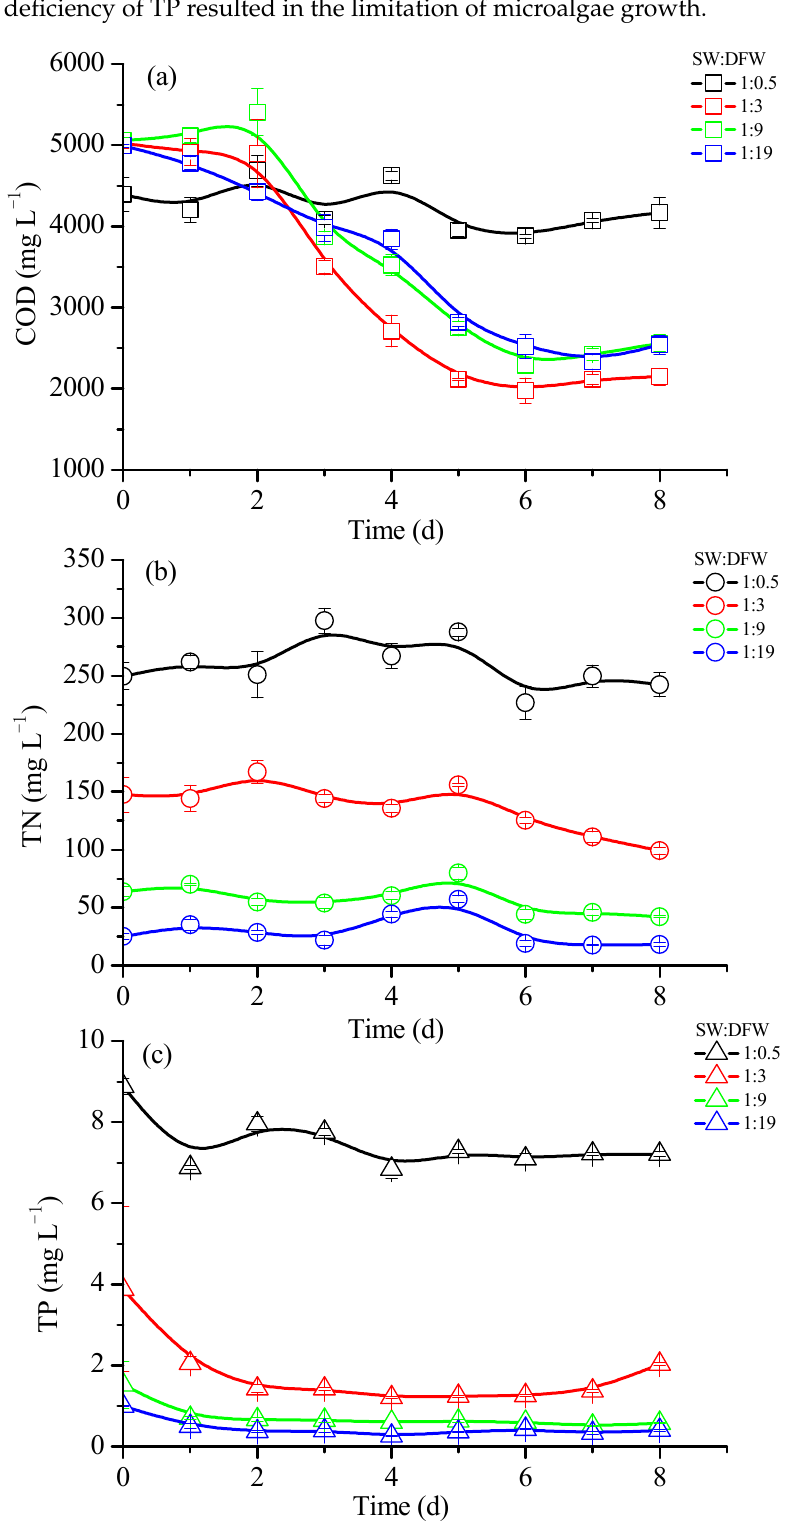
Figure 2. Removal performance of COD ( a ), TN ( b ) and TP ( c ) by C. pyrenoidosa cultured in mixed wastewater with different ratios of swine wastewater (SW) to diluted furfural wastewater (DFW). The COD values of mixed wastewaters at the mix ratios of SW:DFW = 1:3, 1:9 and 1:19 reached a stable level and varied only slightly after 6 d. However, we cannot confirm whether the residual COD are recalcitrant COD or not. The main composition of the re- maining COD may be the recalcitrant organic substances that cannot be easily absorbed